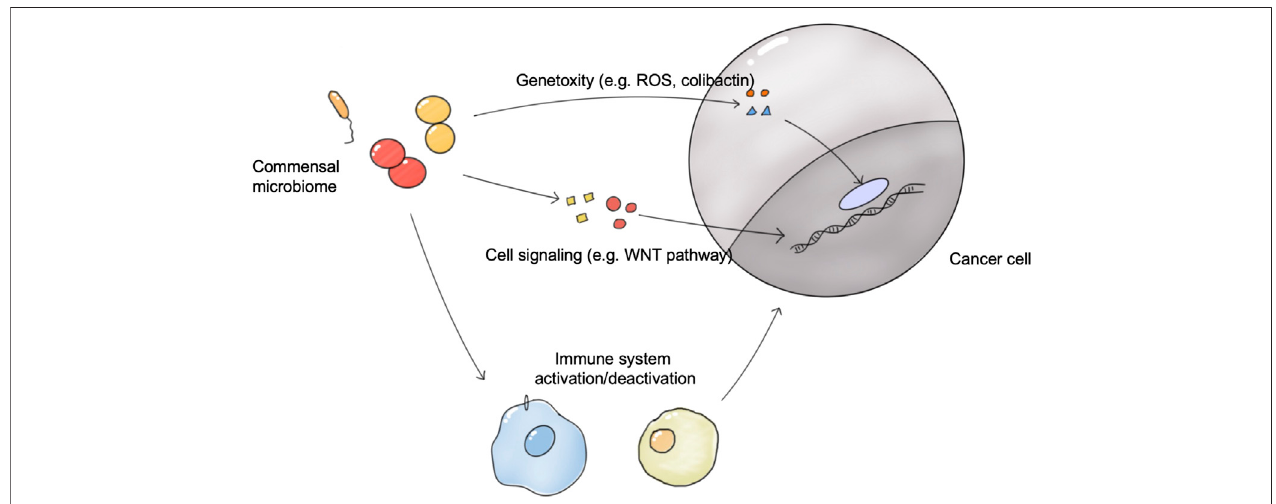
FIGURE2| Theconnectionsbetweenthe commensal microbiome and tumors. Themicrobiomedirectly induces tumorigenesis viagenotoxicity and the disrupted cell signaling pathway. The microbiome in organs and tumors in fl uences the activation status of antitumor immune system responses, and thus affects the growth of tumors and tumor therapy outcomes.; Abbreviation: ROS, React oxygen